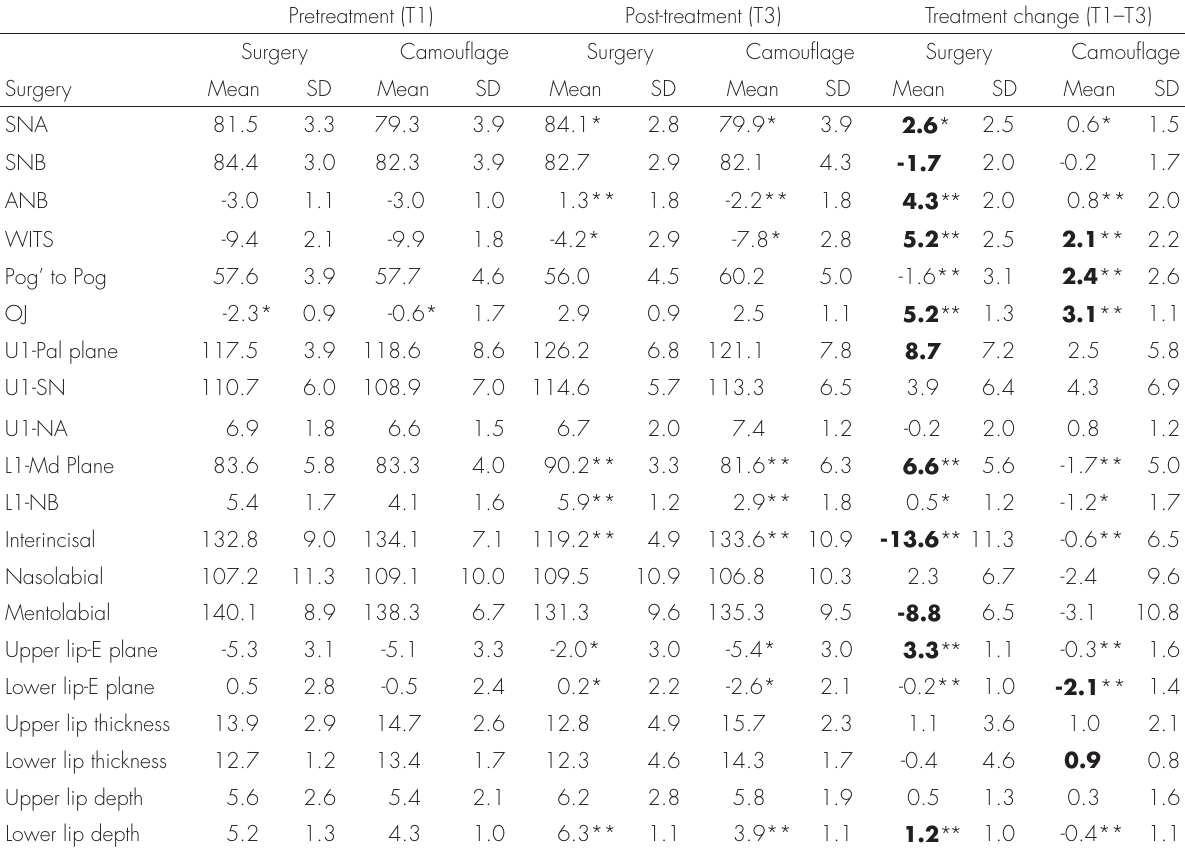
* Statistically significant difference between treatment methods, p < 0.05, ** p < 0.01 Bold values denote statistically significant difference between time points (T1–T3), p <